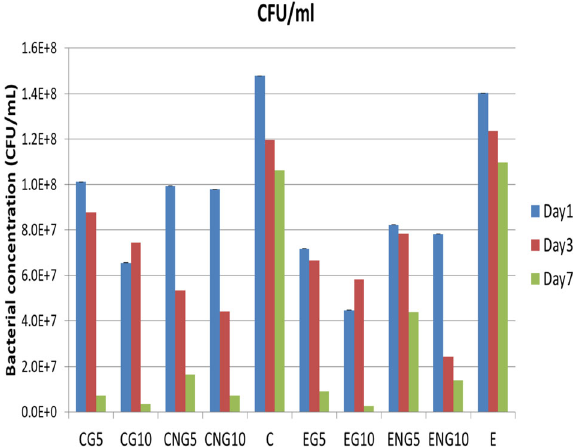
Fig. 3 CFU/mL of commercial composite groups and experimental novel composite groups at days one, three, and